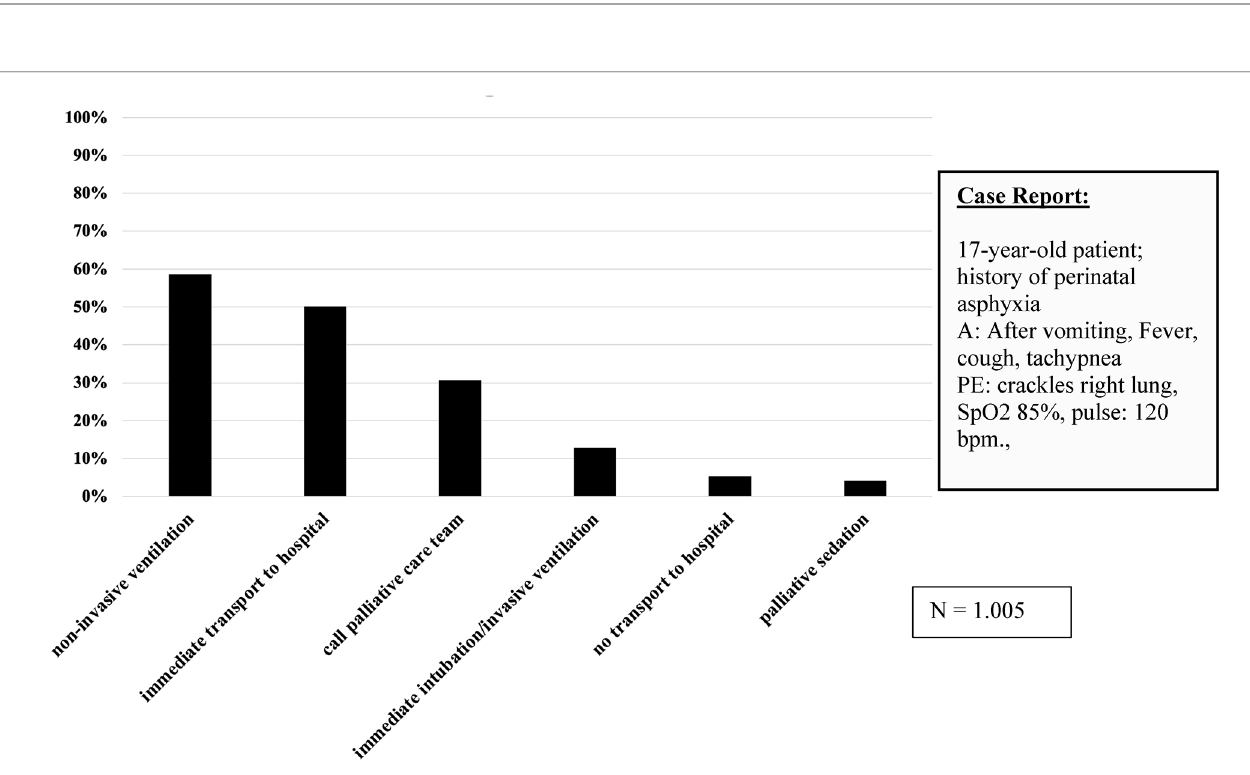
FIGURE 2 Remembered treatment/outcome of EMS-operations. EMT and EMP reported their experiences regarding the last remembered prehospital EMS- response in children/adults with a life limiting conditions. In outcome adults had a reported signi fi cant lower number of ROSC and children were transported more frequently to the hospital. CPR, cardiopulmonary resuscitation; ROSC, recovery of spontaneous circulation; G.P., general practitioner).